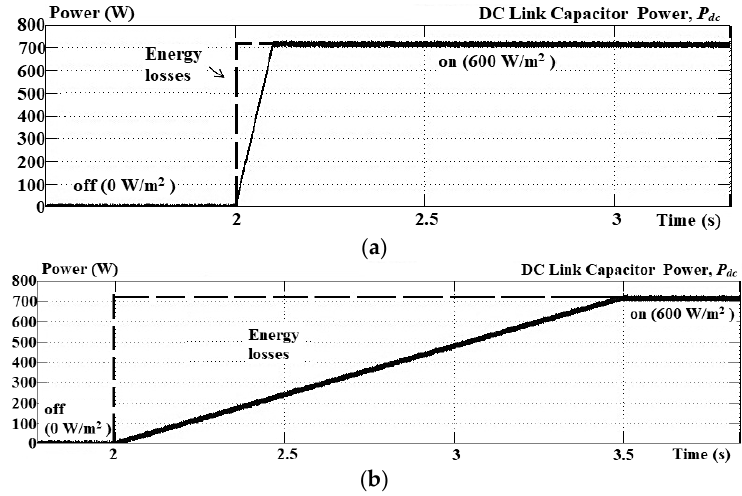
Figure 12. Simulation results of DC link capacitor power under off–on operation between PV and SAPF using ( a ) step size error cancellation and ( b ) direct control in self-charging algorithms.